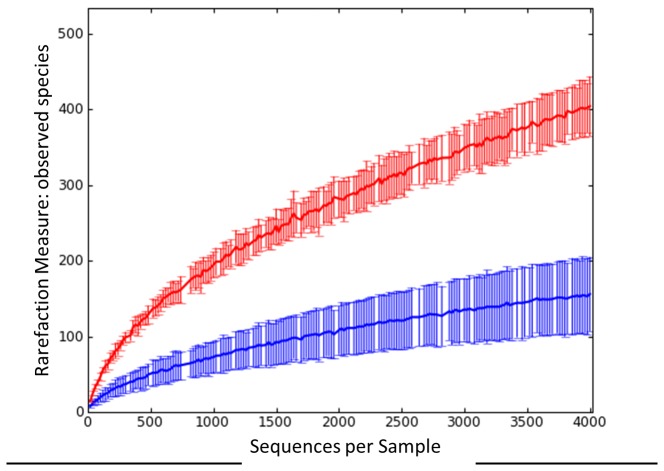
Rarefaction curves generated for 16S rDNA gene sequences from stool samples of breast-fed infants and adults.Curves show the observed species in the fecal microbial communities of breast-fed infants (blue, n=12) and adults (red, n=6).